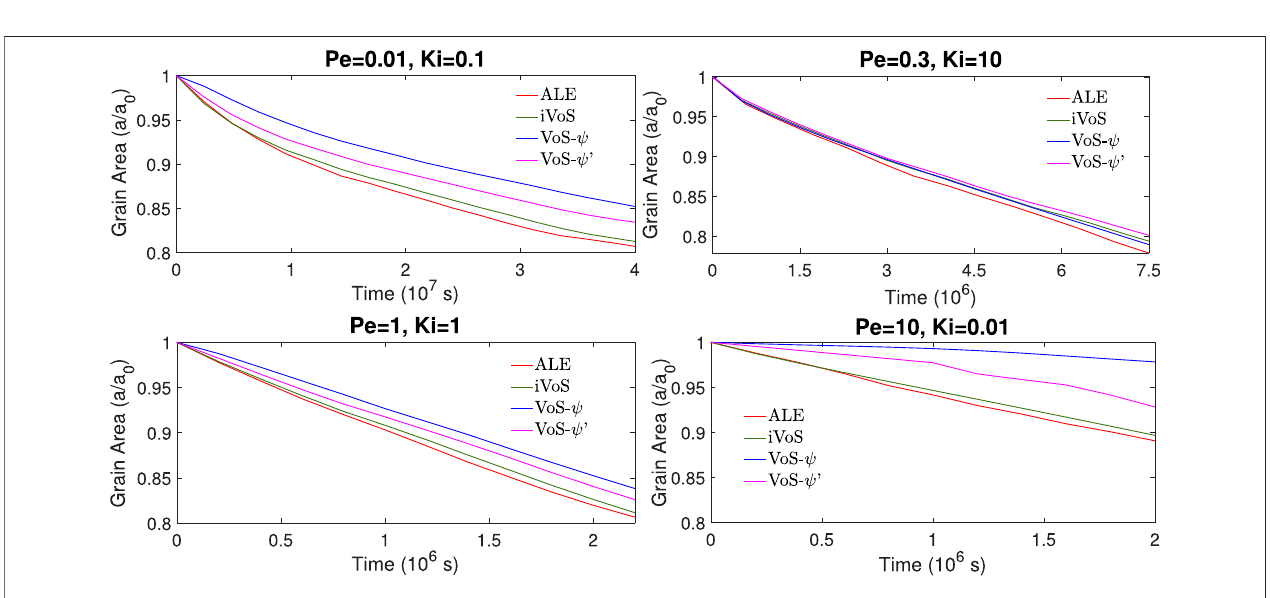
FIGURE 6 | Evolution of the solid surface area during numerical simulation of dissolution in a 2D micromodel at four different regimes.